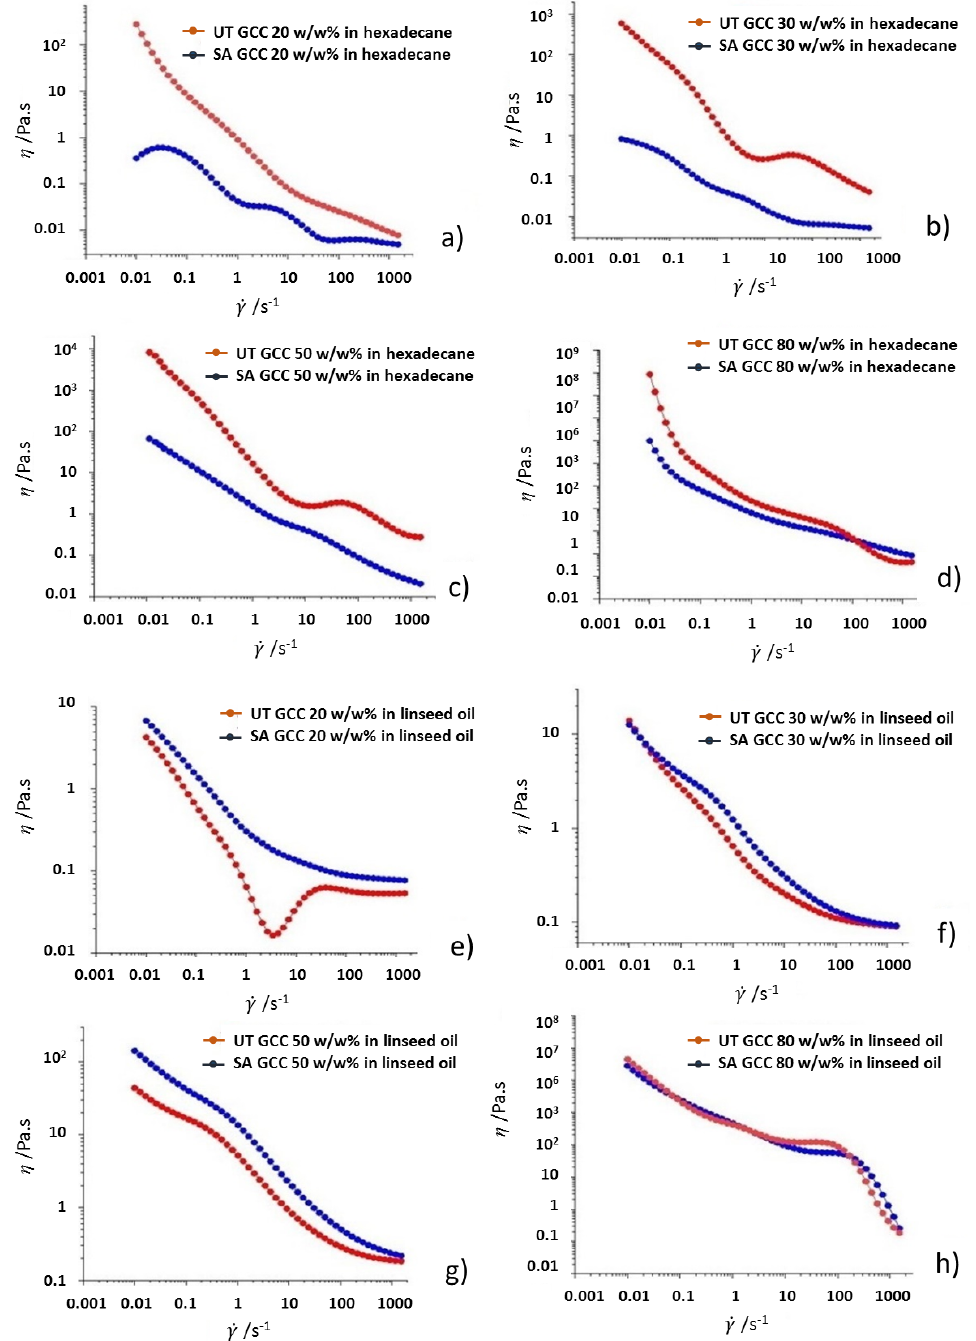
Figure 1: Dynamic viscosity of untreated and surface treated GCC suspensions in hexadecane at increasing solids content: (a) 20 w/w%, (b) 30 w/w%, (c) 50 w/w%, (d) 80 w/w%, and linseed oil e) to h).